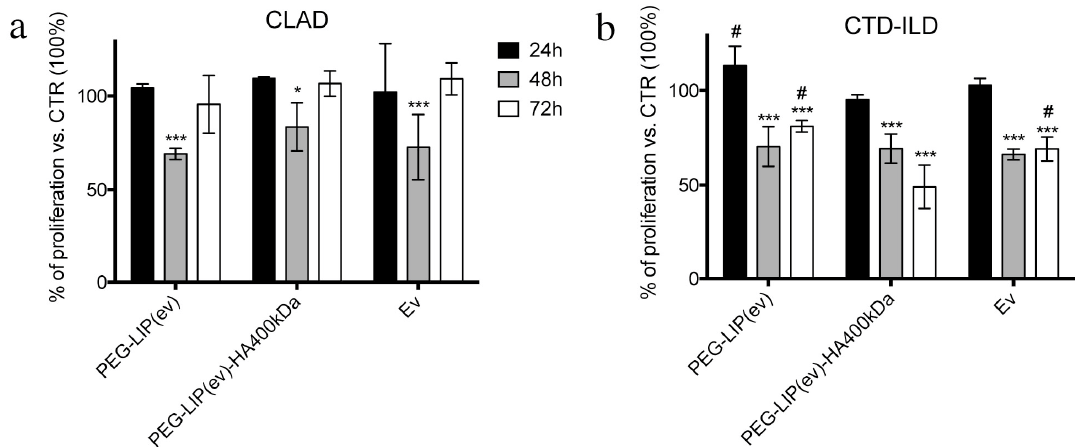
Figure 5. Cell proliferation analysis by flow cytometry of LFs derived from ( a ) CLAD and ( b ) CTD-ILD treated with liposomes loaded with everolimus and everolimus alone (50 nM). Data are represented as mean ± SD of CFSE signals read by flow cytometer for each sample. ***, p < 0.001 vs. CTR; *, p < 0.05 vs. CTR; #, p < 0.001 vs. PEG-LIP(ev)-HA400kDa (One-way ANOVA followed by Dunnett post-hoc).